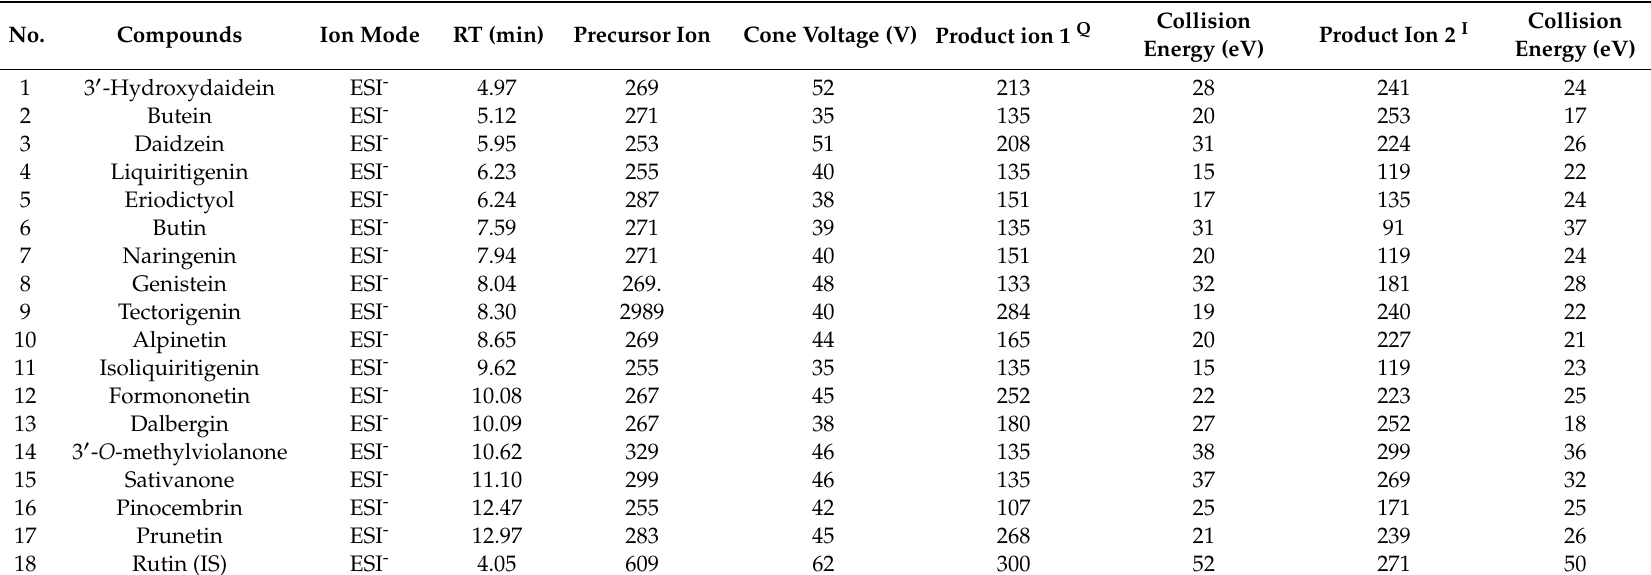
Table 1. MS / MS parameters for 17 target